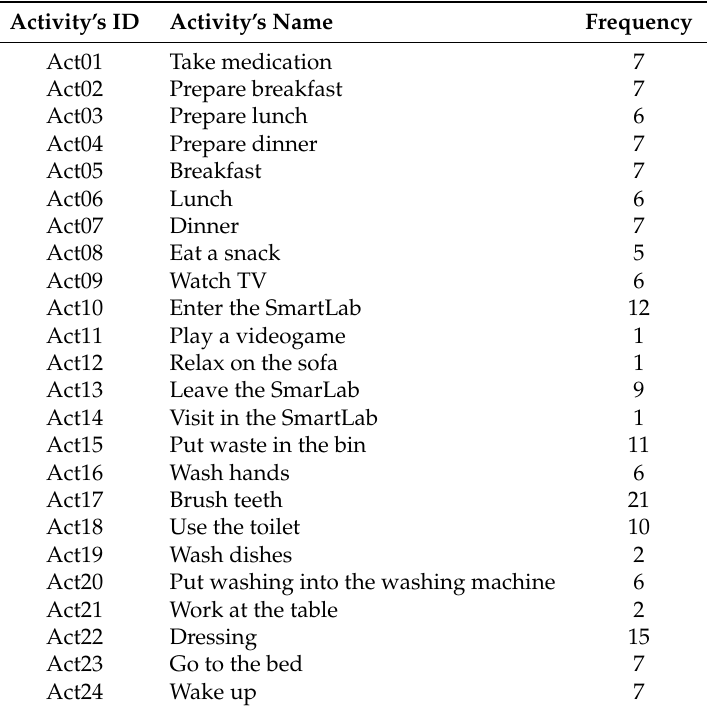
Table 1. Activities recorded in the